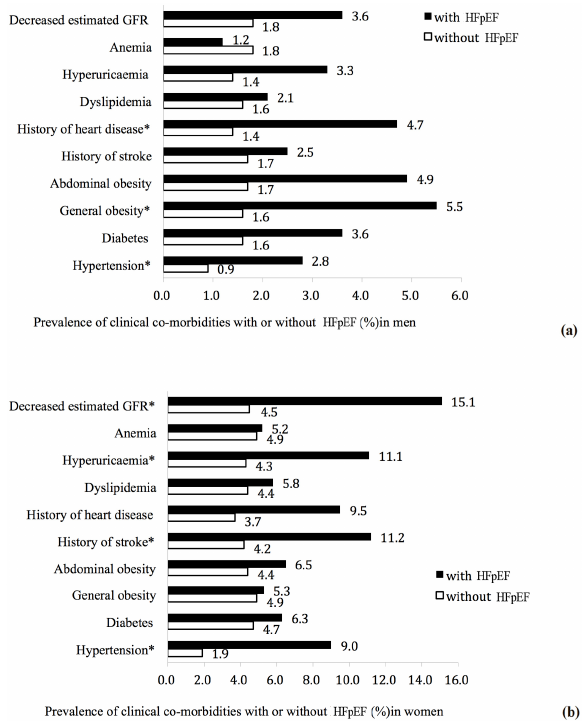
Figure 3. Prevalence of clinical co-morbidities with or without HFpEF (%) in men ( a ) and women ( b ). * p < 0.05, subjects with HFpEF vs. subjects without HFpEF. Table 2. Results of multivariable regression analyses of potential risk factors for heart failure with preserved ejection fraction.